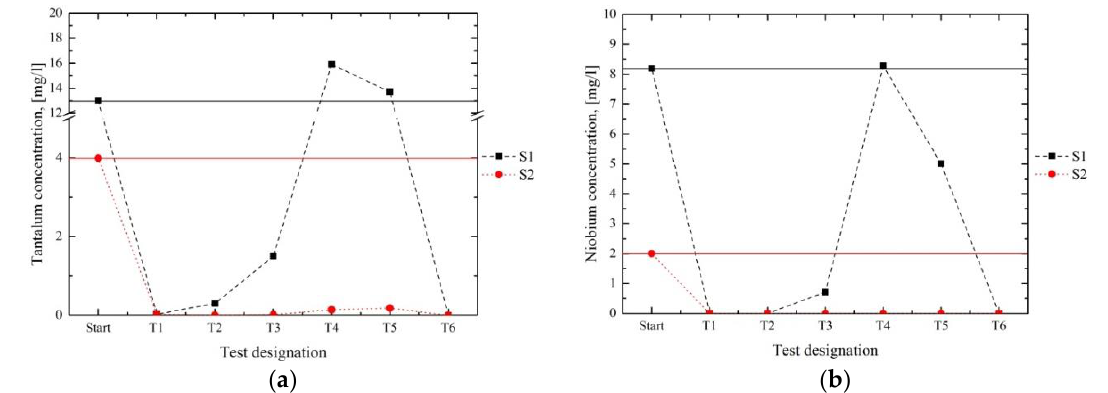
Figure 10. Concentration of tantalum ( a ) and niobium ( b ) in the initial solutions (start, continuous line) and in the filtrates of series 1 [3].